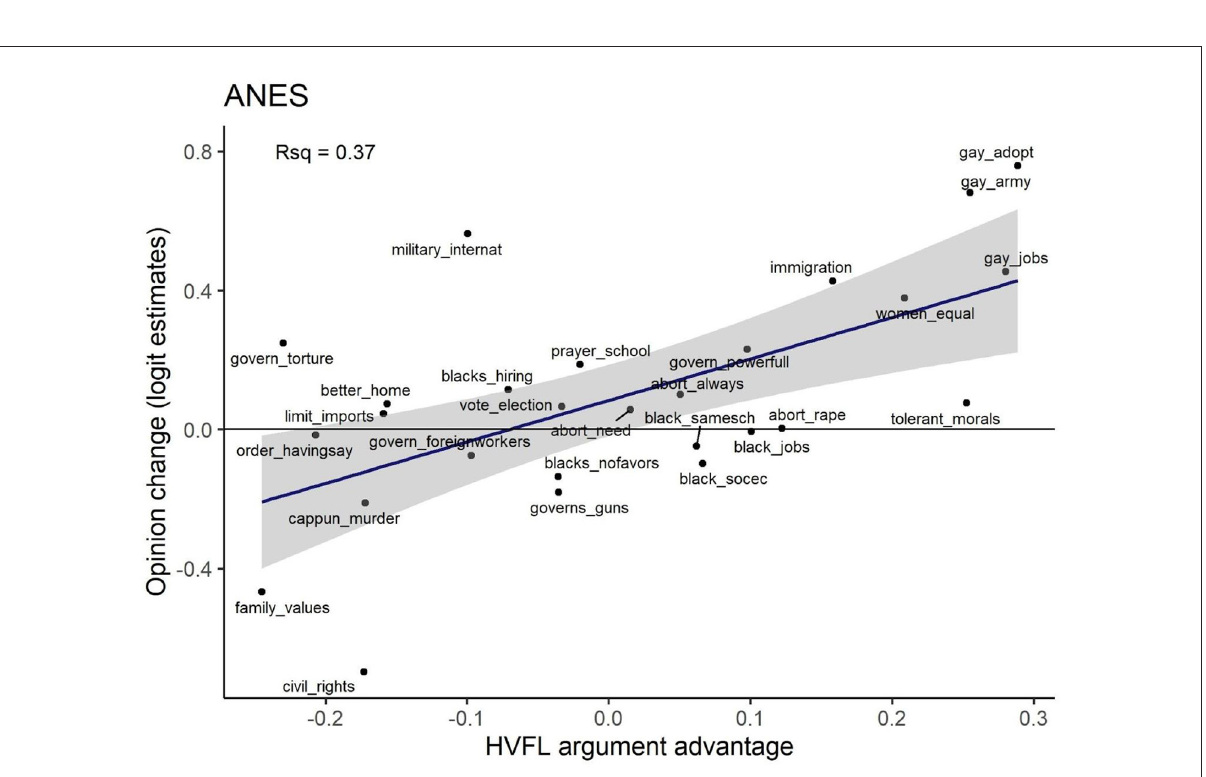
FIGURE3 Opinion change is related to the HVFL argument advantage of the opinion. The 27 dots represent items for moral opinions in the American National Election Studies. The labels are our abbreviations of the items (see Supplementary Table 1 for the full items). The y-axis represents estimated opinion change in log odds per 10 years. The x-axis represents the HVFL argument advantage of the opinion stated in the